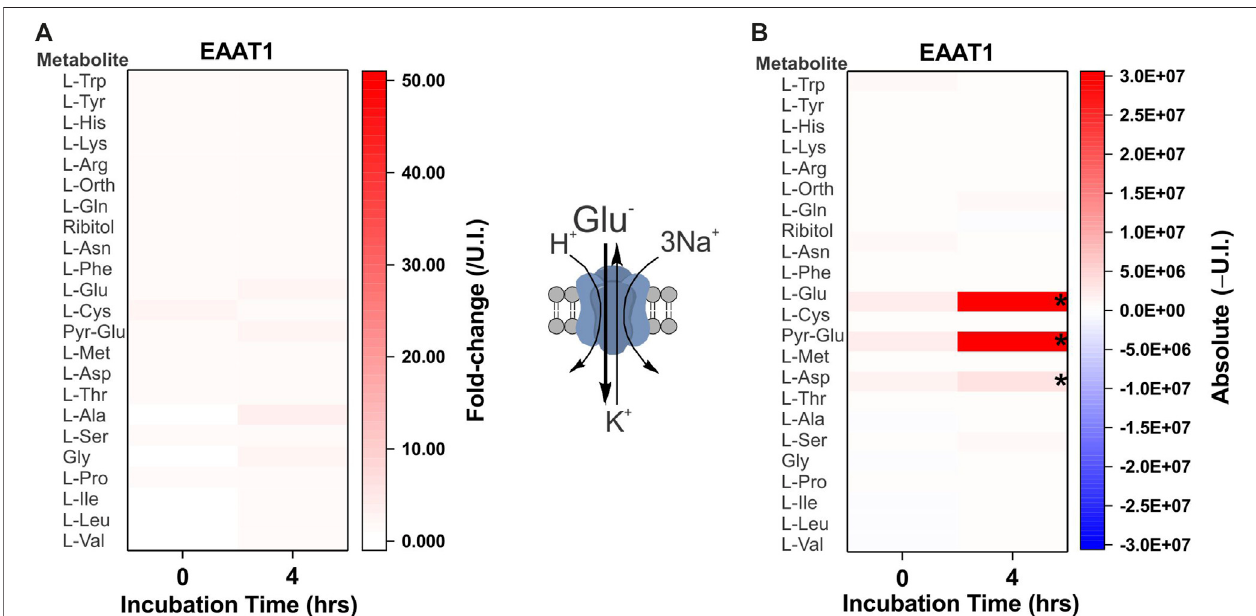
FIGURE 5 | Comprehensive substrate pro fi le of glutamate transporters. Oocytes were injected with 5 ng of cRNA for EAAT1 or remained un-injected for a 4-day expression period in OR2 + (pH 7.8). Amino acid accumulation was analyzed as fold-change relative to un-injected (U.I.) oocytes (A) or as absolute ( Δ ) change from U.I. oocytes (B) after a 4 h incubation in modi fi ed L-15 medium. The known speci fi city and stoichiometry of the transporters are shown as a cartoon. A more intense red for the same aminoacidat 4 h indicates active accumulation.Pyro-glutamic acid(2-oxo-proline) and ornithine areincluded inallheatmaps asthey areknown GC-MS derivatives of glutamate and arginine, respectively. The internal standard ribitol was also included in each heat-map as a negative control to indicate any deviation from fold-change of 1 ± 0.1 or 10% of the absolute value. * Indicates a difference in the means between the two time points at the p < 0.05 level using a paired t -test as calculated from the absolute mass spectrometer raw values. The fi gures are a representative example of 3 experiments with n (cid:2) 12 transporter-expressing and un- injected oocytes per